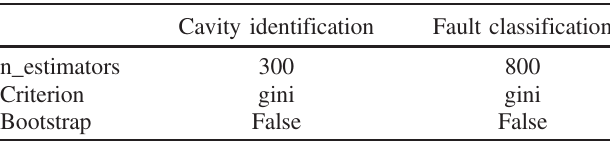
TABLE I. Results of hyperparameter tuning for each random forest model.